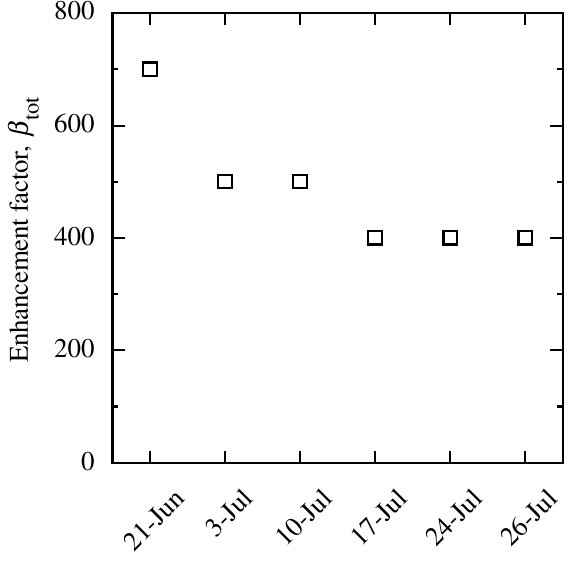
FIG. 6. Progress in conditioning.